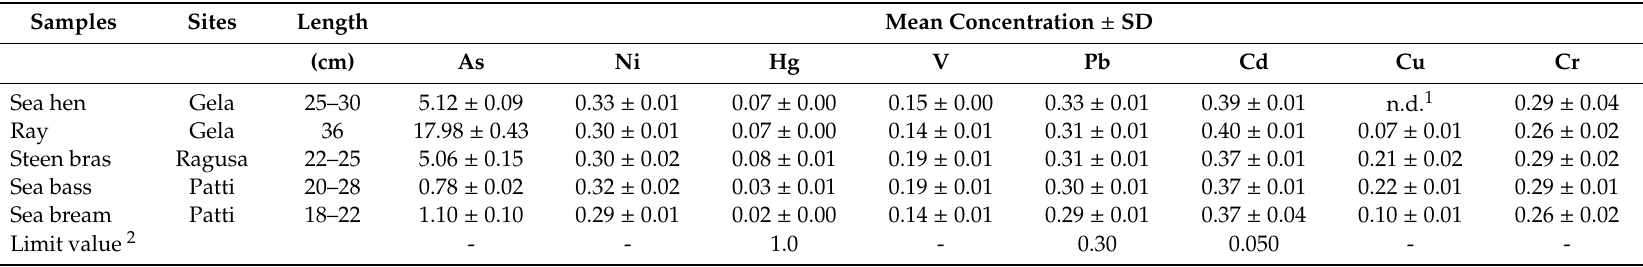
Table 7. Concentration (mg kg − 1 wet weight, mean ± SD) of potentially toxic elements in fish samples from Gela Gulf compared to samples from two di ff erent Sicilian